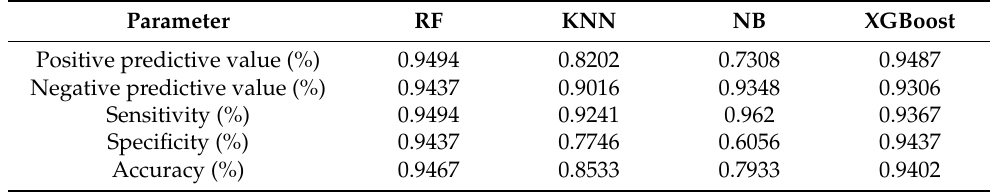
Table 4. Model performance in this study.